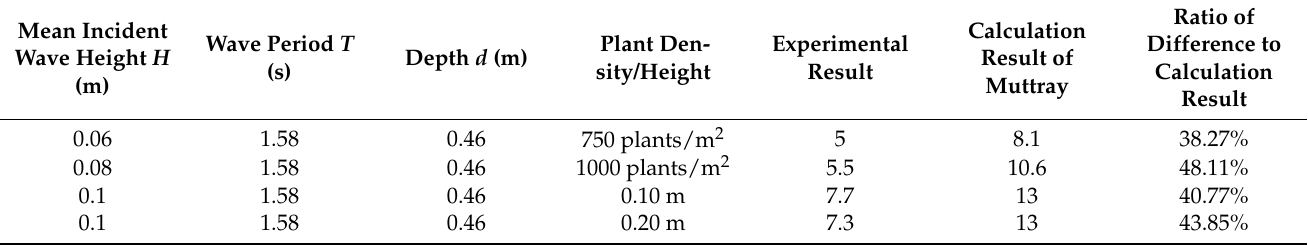
Table 4. Comparison between the run-up height of the vegetated honeycomb-type revetment and that calculated using Muttray’s formula. (Unit: m).